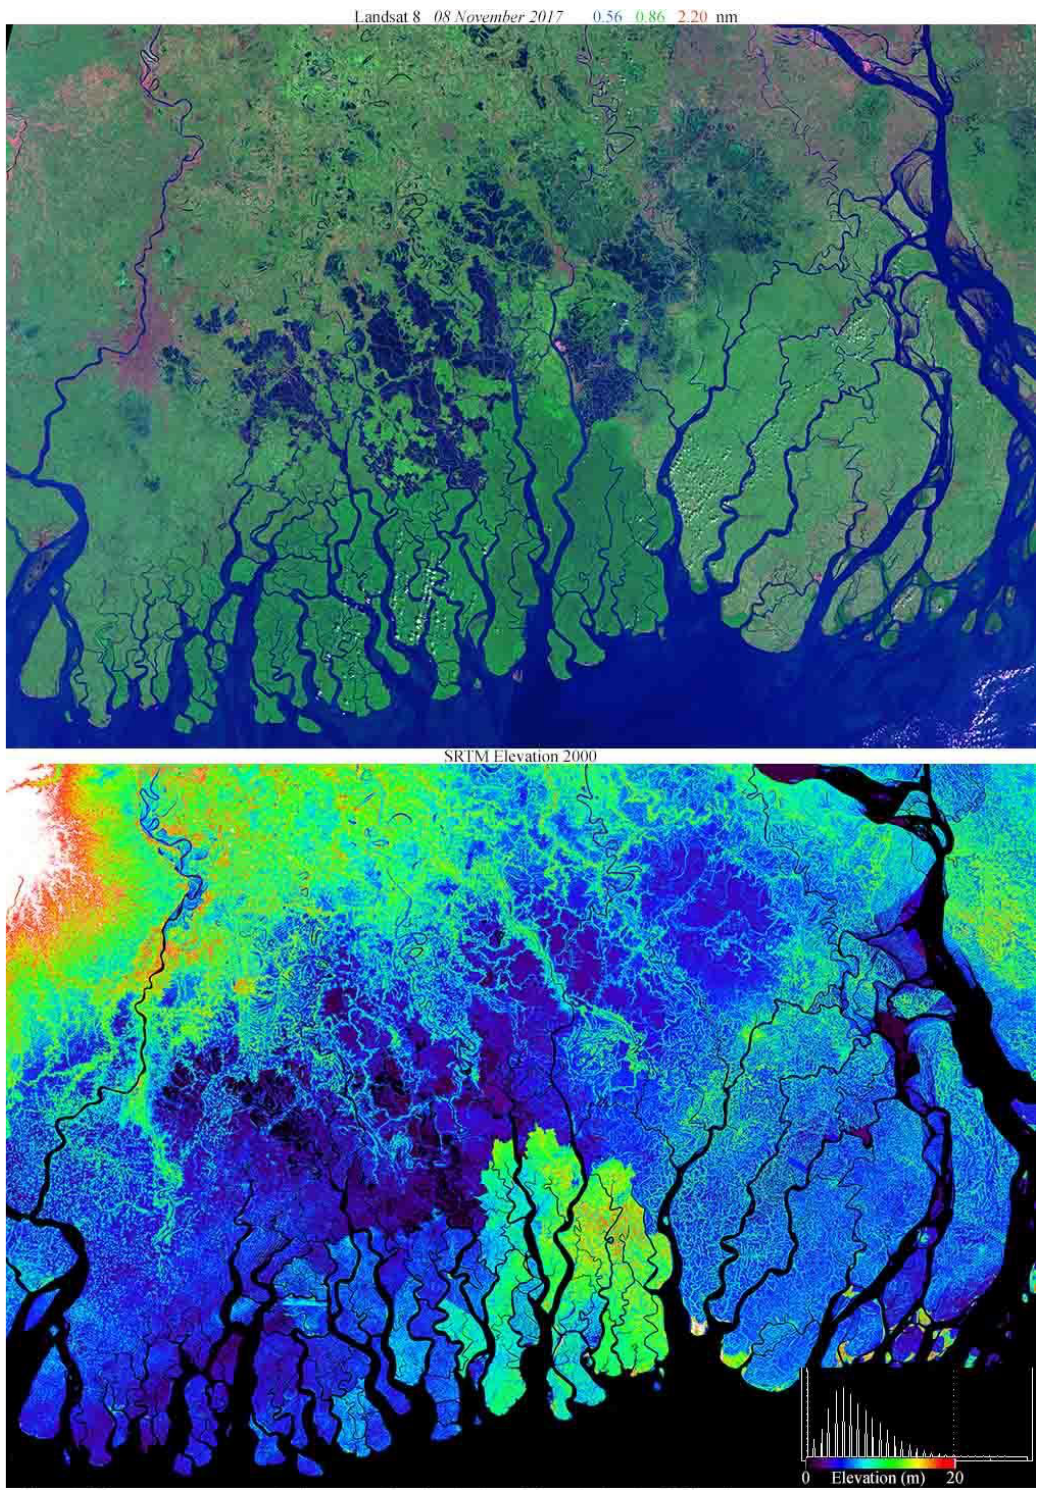
Figure 12. Current (circa 2017) post-monsoon agriculture and aquaculture distribution and elevation. Landsat 8 false color composite (top) shows strong contrast between aquaculture ponds (black) and post-monsoon agriculture (light green). SRTM elevations show a ~4 m discontinuity between polder/pond level (purple + blue) and tree canopy height (cyan + green) on embankments. Tree canopy in Sundarban forest ranges from 4 to 20 m by species. Top image is a false color composite: red = SWIR reflectance; green = NIR reflectance; blue = visible reflectance (Landsat 8 OLI bands 7, 5, and 3). Bottom image is a single-band elevation image with color ramp shown in lower right.